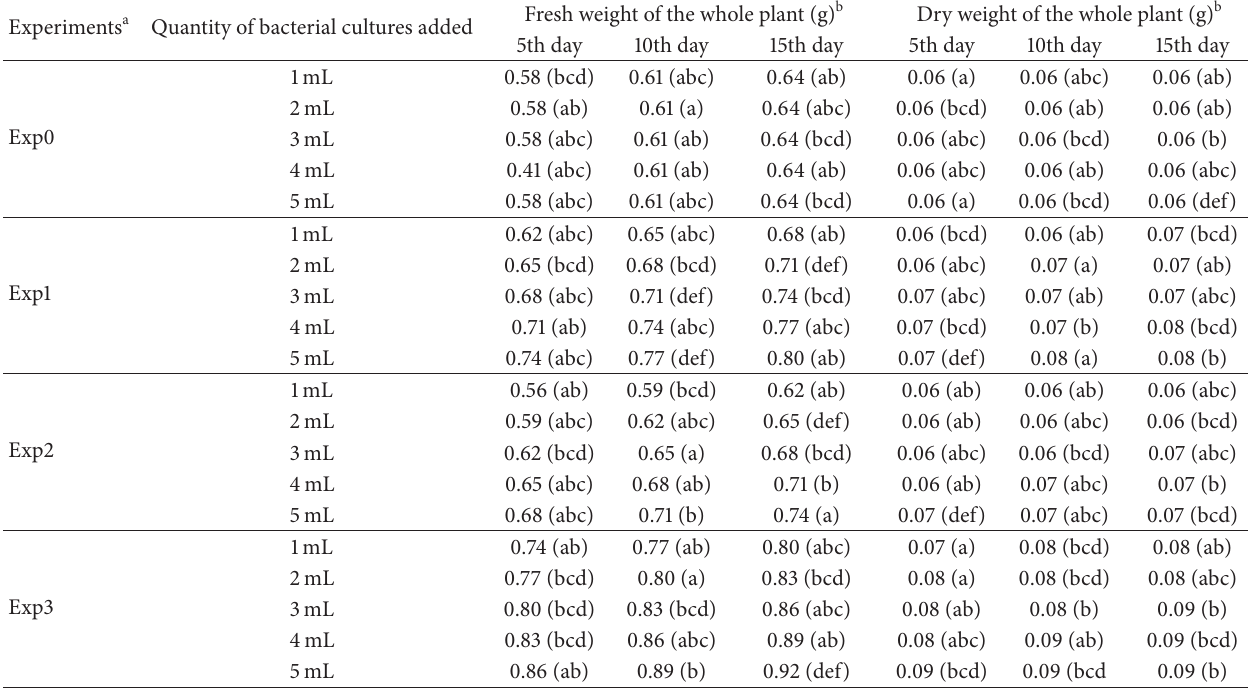
Table 6: Fresh weight and dry weight of whole plant of Vigna unguiculata grown on vermiculite supplemented with Bacillus cereus , with Pseudomonas spp., and with their consortium (1:1) at five different concentrations (1, 2, 3, 4, and 5 mL) on the 5th, the 10th, and the 15 days and in the